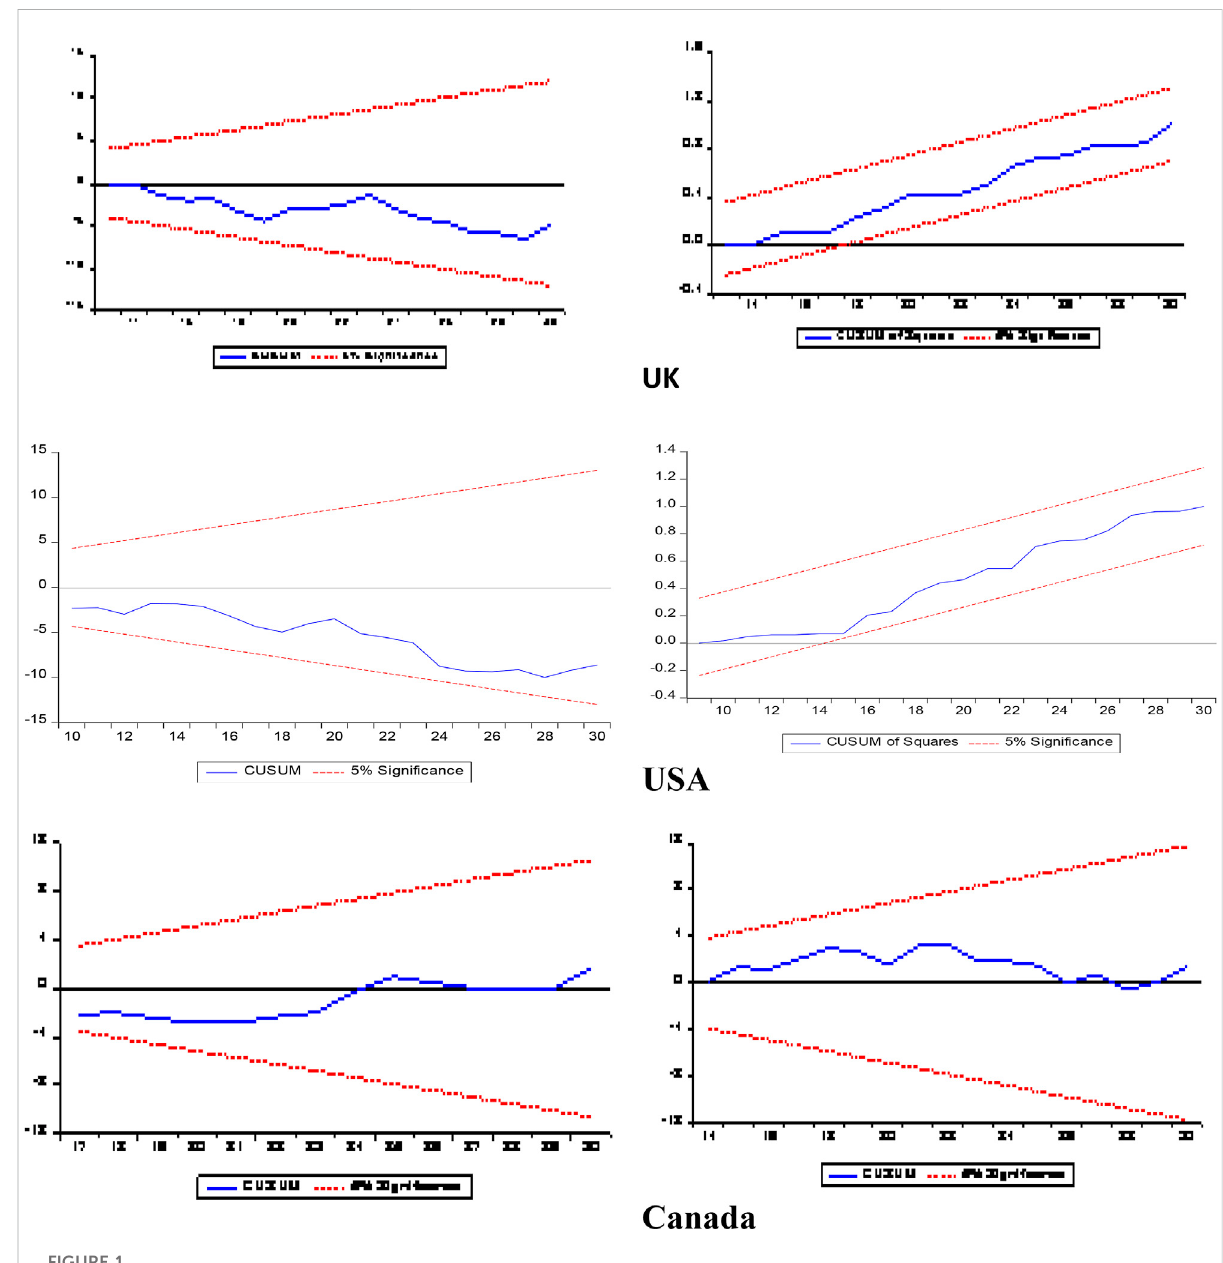
FIGURE 1 Parameters